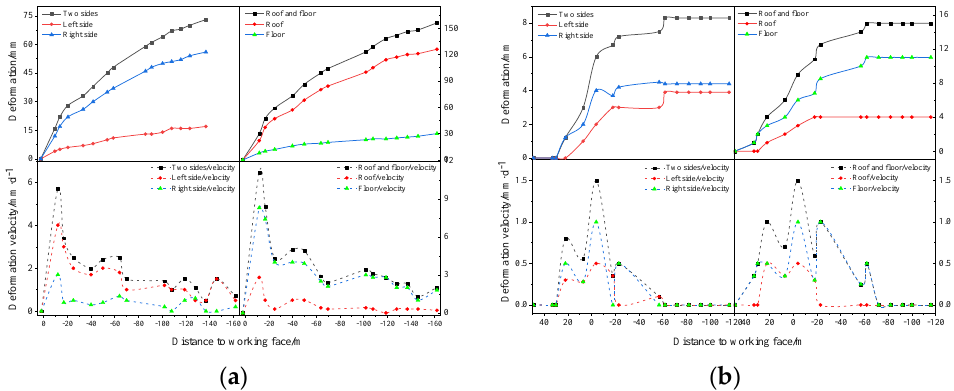
Figure 9. Comparison of deformation amount and deformation velocity of roadway surrounding rock ( a ) measuring point 7# ( b ) measuring point 8#.